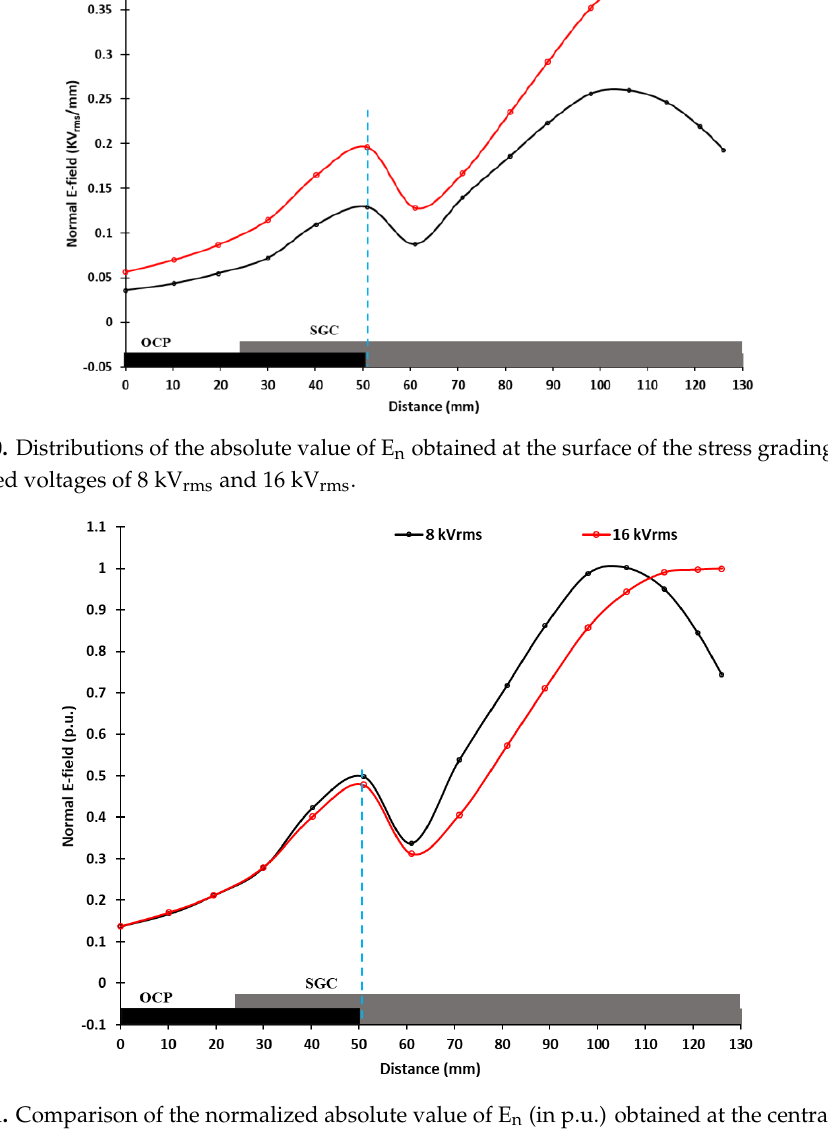
Figure 11. Comparison of the normalized absolute value of E n (in p.u.) obtained at the central line on the surface of the stress grading system for applied voltages of 8 kV rms and 16 kV rms .